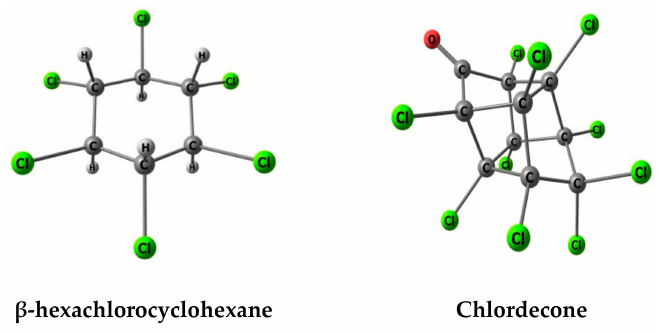
Figure 2. Pesticide computational